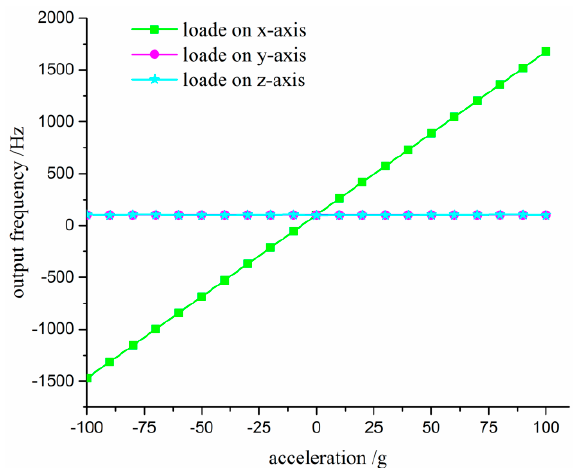
Figure 22. The graph of the original output frequency versus the acceleration loaded in three axes.